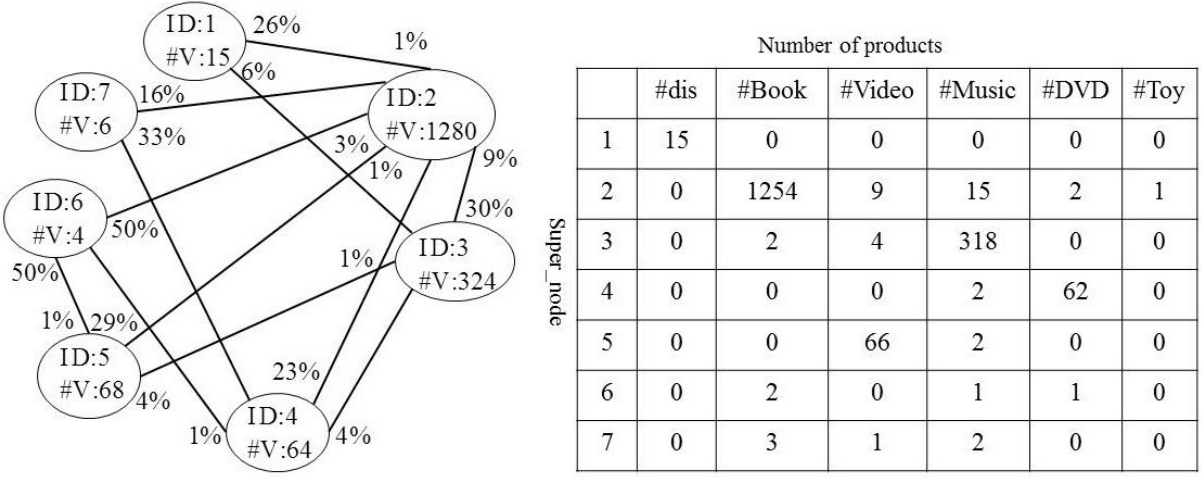
ures 5 through 9 and Tables 3 and 4 are used to discuss the experimental